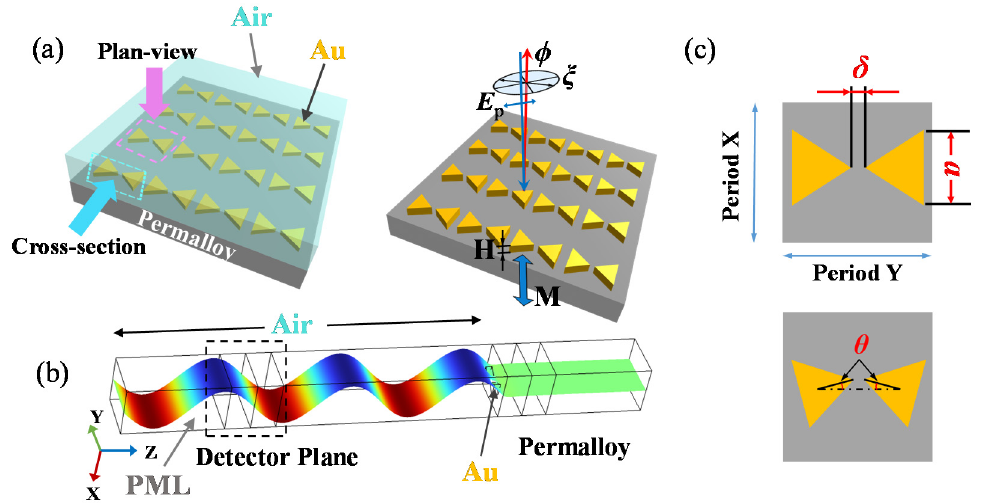
Figure 1. Schematic of the periodic model geometry for calculation of the PMOKE. ( a ) General schematic showing the Au nanostructure, magnetic region, air region, and p-polarized light incidence mode (the polarized light is incident vertically, and the polarization angle is 0 ◦ ). ( b ) The parameters that affect the PMOKE discussed in this paper. ( c ) The X directional component of the electric field, which is the result of the MO rotation induced by the PMOKE.